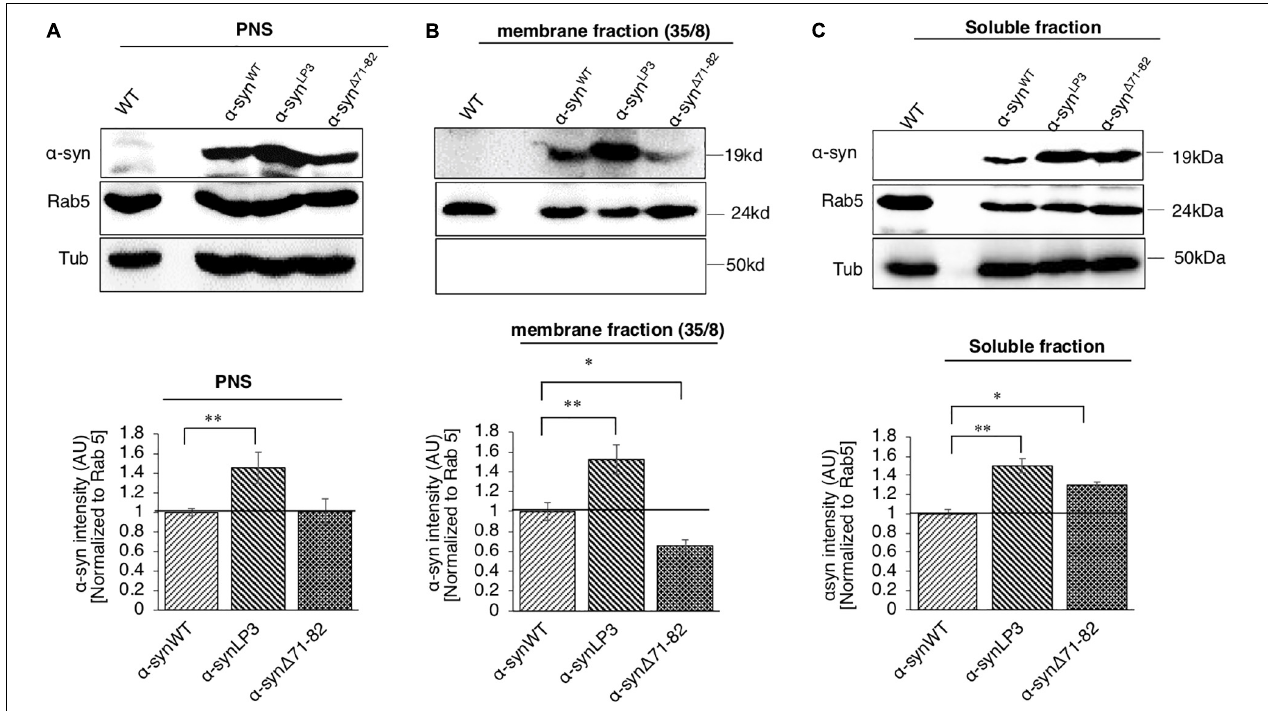
FIGURE 6 | α -Syn binds membranes via the NAC region. (A) Postnuclear supernatant (PNS) shows the extent of α -syn expression in larvae. Quantification analysis of the PNS fraction shows the expression of α -syn in larval brains. Note that α -syn LP3 larval brains contain a higher amount of α -syn compared to α -syn WT ( p < 0.01). The level of α -syn in α -syn (cid:49) 71 − 82 larval brains was similar to what was seen in α -syn WT larval brains. (B) Subcellular fractionation of larval brains on sucrose step gradients indicates that α -syn is present in the membrane fraction and in the soluble fraction. Quantification analysis of the light membrane fraction (35/8) indicates a significantly high level of α -syn with membranes in α -syn LP3 larval brains ( p < 0.01). Note that a significant decrease of membrane bound α -syn is seen in α -syn (cid:49) 71 − 82 larval brains compared to α -syn WT ( p < 0.05). (C) Quantification of the soluble fraction shows an increase level of α -syn levels in α -syn LP3 ( p < 0.01) brains compared to α -syn WT brains. Note that the level of α -syn levels in α -syn (cid:49) 71 − 82 brains was increased comparable to α -syn WT brains ( p < 0.05). Antibodies against α -syn, Rab5 (for membranes), and Tubulin (loading control) were used. The ratio of relative intensity of α -syn was normalized to the intensity of Rab5 positive for membranes and then normalized to α -syn WT . The level of intensity in α -syn WT was set at 1. The ratio of the relative intensity of proteins normalized to Rab5 is shown from three independent experiments ( n = 3, AU = arbitrary units). The quantitative analysis represents mean ± SEM. ∗ p < 0.05, ∗∗ p <